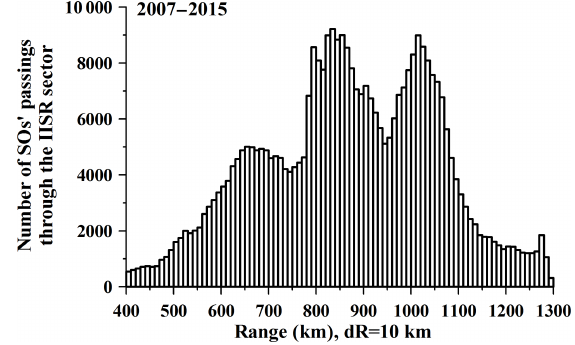
Figure 11. Altitude distributions of space objects in 2007–2015.